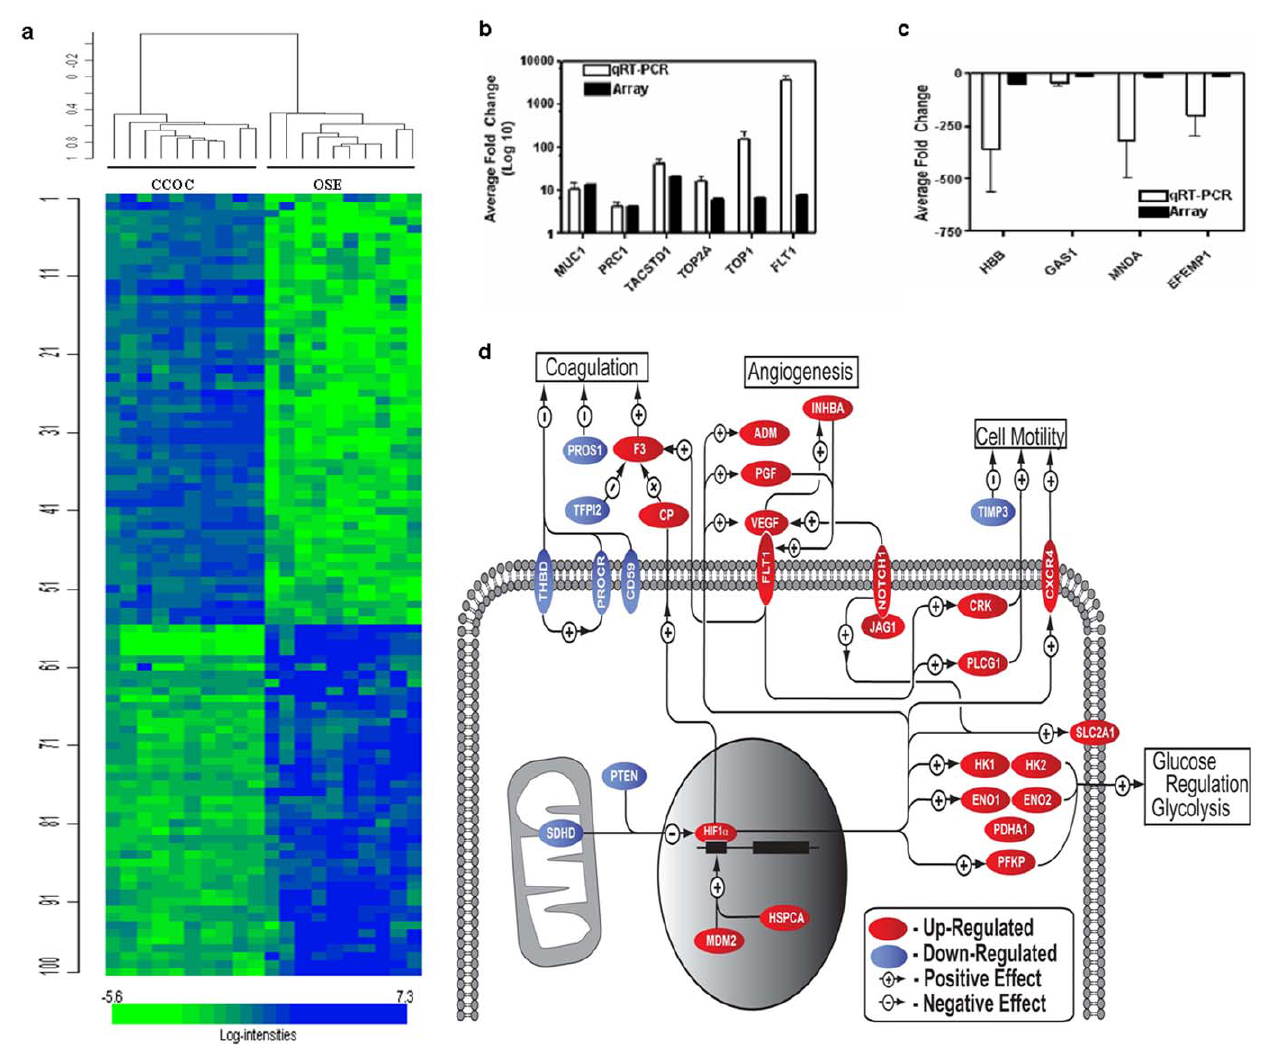
Figure 1. Whole genome expression profiling of clear cell ovarian tumors. ( a ) Graphic representation of whole genome expression profiling of the Clear Cell Ovarian Cancer Specimen (CCOC) and Ovarian Surface Epithelium (OSE). ( b ) and ( c ) Comparison of qRT-PCR data and microarray data of the six overexpressed and four underexpressed genes used for validation ( d ) Pathway analysis of differentially regulated genes identified in the clear cell ovarian cancer microarray. Genes included in the analysis were required to have a fold change $ 1.5. Multiple probe sets were averaged for each gene. Red , gene is up-regulated. Blue , gene is down-regulated.